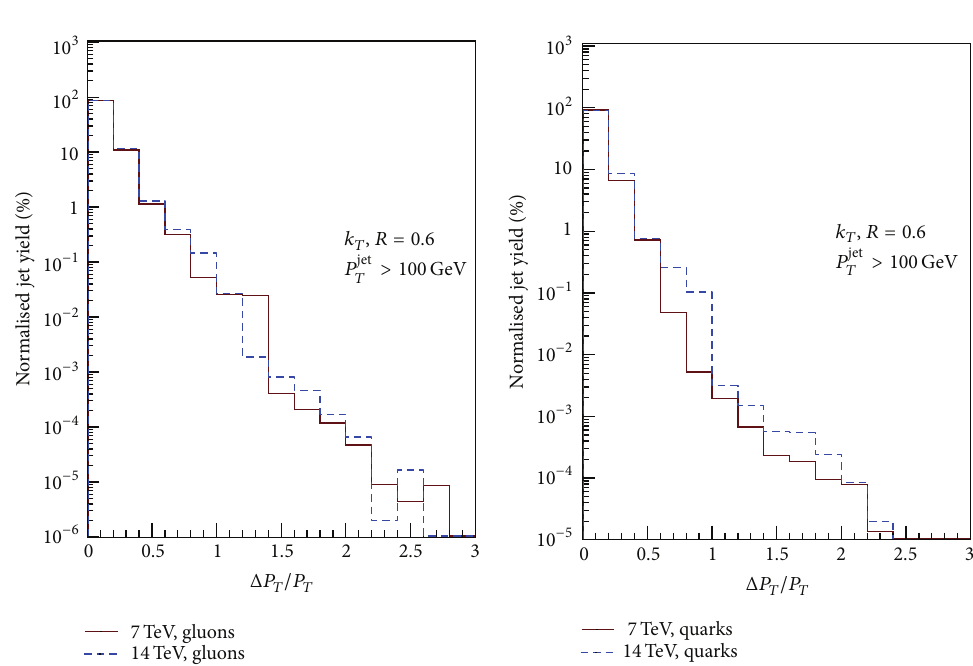
Figure 1: Distribution of Δ𝑃 𝑇 /𝑃 𝑇 for the matched quark and gluon jets with 𝑃 jet 𝑇 > 100 GeV at √𝑠 = 7 TeV compared to √𝑠 = 14 TeV for 𝑘 𝑇